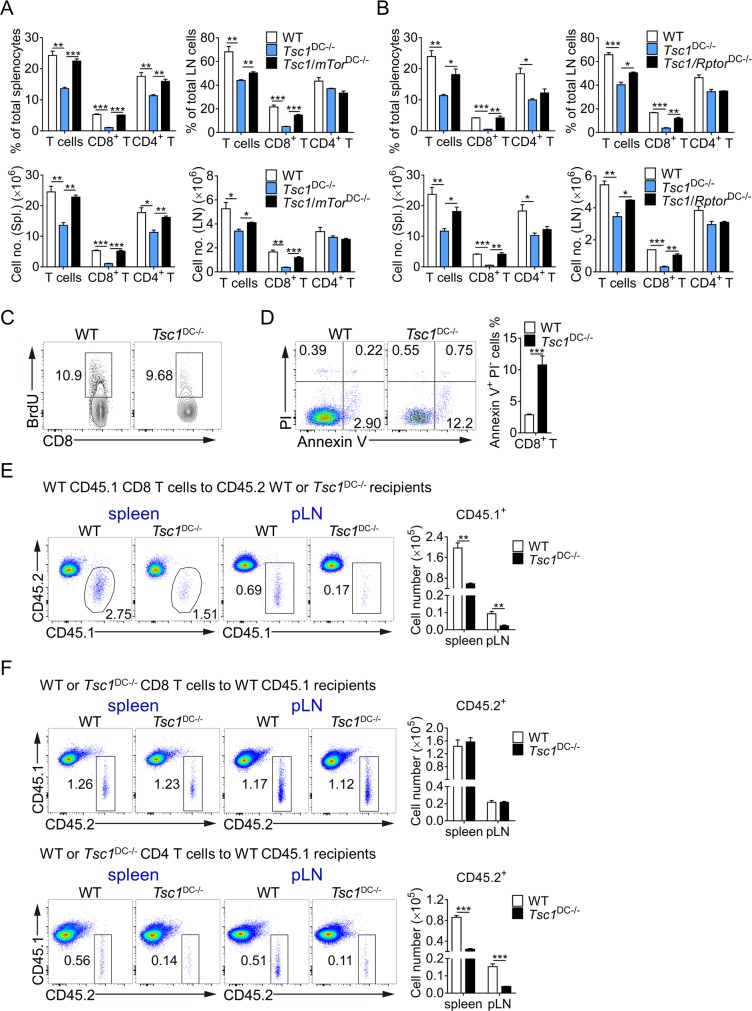
mTORC1 in the DC compartment controls CD8+ T-cell survival.(A and B) The percentages and numbers of total T cells (CD3+) and T-cell subsets (CD8+ and CD4+ T cells) of the Spls. and pLNs from WT, TSC1DC-KO, and TSC1/mTORDC-DKO mice (n = 3) (A) or TSC1/RaptorDC-DKO mice (n = 3) (B) were analyzed by flow cytometry, and the cell percentages were calculated accordingly. These experiments were repeated twice with similar results. The data are presented as means ± SEM (*p < 0.05, **p < 0.01, and ***p < 0.001; analyzed by Student’s t test). (C) The 6–8-week-old WT and TSC1DC-KO littermates (n = 3) were i.p. injected with 1 mg BrdU per mouse and then fed with 0.8 mg/ml BrdU containing water for 7 days. The splenocytes were isolated and stained for BrdU. The percentages of BrdU+ CD8+ T cells were shown. This experiment was conducted twice, and similar results were obtained. (D) Spleens from WT and TSC1DC-KO mice (n = 6) were isolated and immediately stained with annexin V and PI; after cell surface marker staining, early apoptotic CD8+ T cells (annexin V+PI−) were calculated. This experiment was repeated twice with similar results. The data are presented as means ± SEM (***p < 0.001, analyzed by Student’s t test). (E) WT CD45.1 donor CD8+ T cells from Spl. (5 × 106 CD8+ T cells) were transferred into WT and TSC1DC-KO recipient mice (n = 3), and the percentages of transferred CD45.1 CD8+ T cells in the Spls. and pLNs were analyzed by flow cytometry after 2 weeks. This experiment was repeated twice with similar results. The data are presented as means ± SEM (**p < 0.01, analyzed by Student’s t test). (F) In total, 5 × 106 CD45.2 donor CD8+ T cells or CD4+ T cells from WT and TSC1DC-KO Spls. were transferred into CD45.1 recipient mice (n = 4), and the percentages of transferred CD45.2 cells in the Spls. and pLNs were analyzed by flow cytometry after 2 weeks. This experiment was repeated twice with similar results. The data are presented as means ± SEM (***p < 0.001, analyzed by Student’s t test). Underlying data are available in S1 Data. BrdU, bromodeoxyuridine; CD, cluster of differentiation; DC, dendritic cell; i.p., intraperitoneally; LN, lymph node; mTOR, mechanistic target of rapamycin; mTORC1, mTOR complex 1; PI, propidium iodide; pLN, peripheral LN; Rptor, regulatory associated protein of MTORc1; Spl., spleen; Tsc1, tuberous sclerosis complex subunit 1; TSC1DC-KO, specific ablation of Tsc1 in the DC compartment; WT, wild-type.